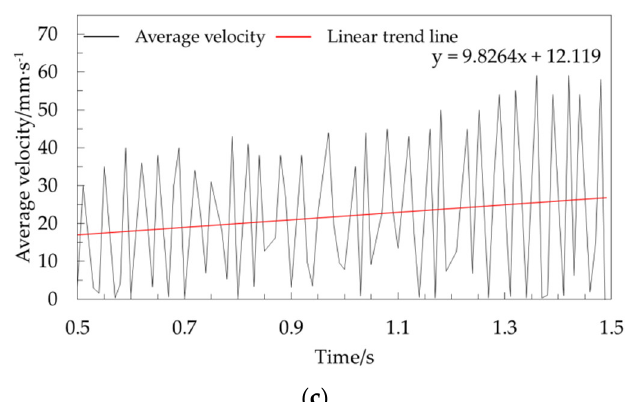
Figure 12. Average velocity in 1 s during the period of periodic pulsation at different half cone angles below 20 mm on the free surface: ( a ) average velocity over 1 s during the period of periodic pulsation at a half cone angle of 30° below 20 mm on the free surface; ( b ) average velocity over 1 s during the period of periodic pulsation at a half cone angle of 45° below 20 mm on the free surface; ( c ) average velocity over 1 s during the period of periodic pulsation at a half cone angle of 60° below 20 mm on the free surface.